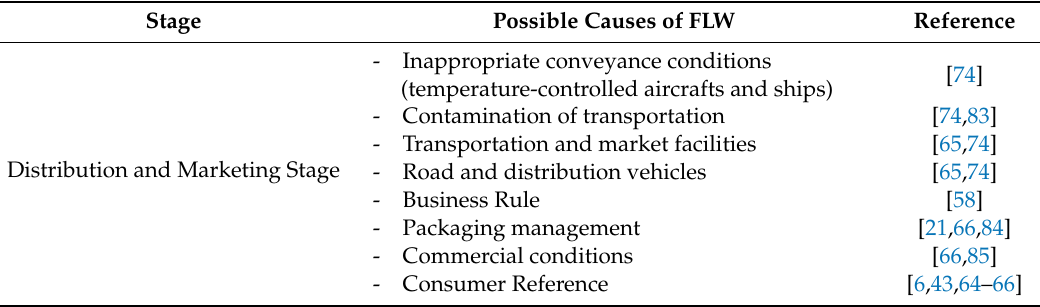
Table 9. Possible causes of FLW at the distribution and marketing stage of